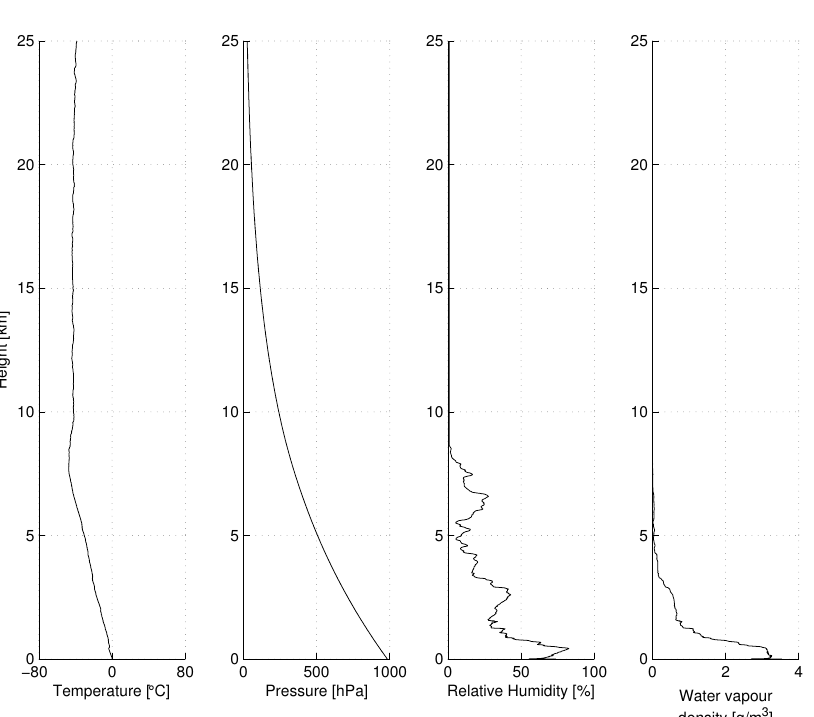
Figure 6. Radiosonde data from 7 February 2011, launched at 11:38